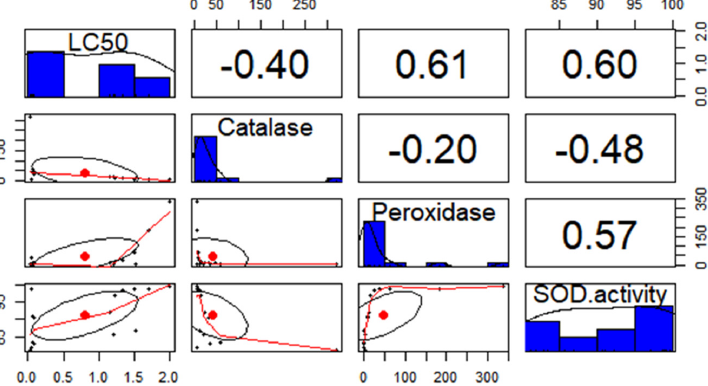
Figure 2. Correlation of LC 50 with the antioxidant enzymes—catalase, peroxidase, and SOD—in Rhyzopertha dominica populations. In this figure, LC 50 and each of the antioxidant enzymes is marked in the histogram on the diagonal, the upper triangular matrix depicts Pearson correlation, and the lower triangular matrix shows a bivariate scatter plot with a fitted line.